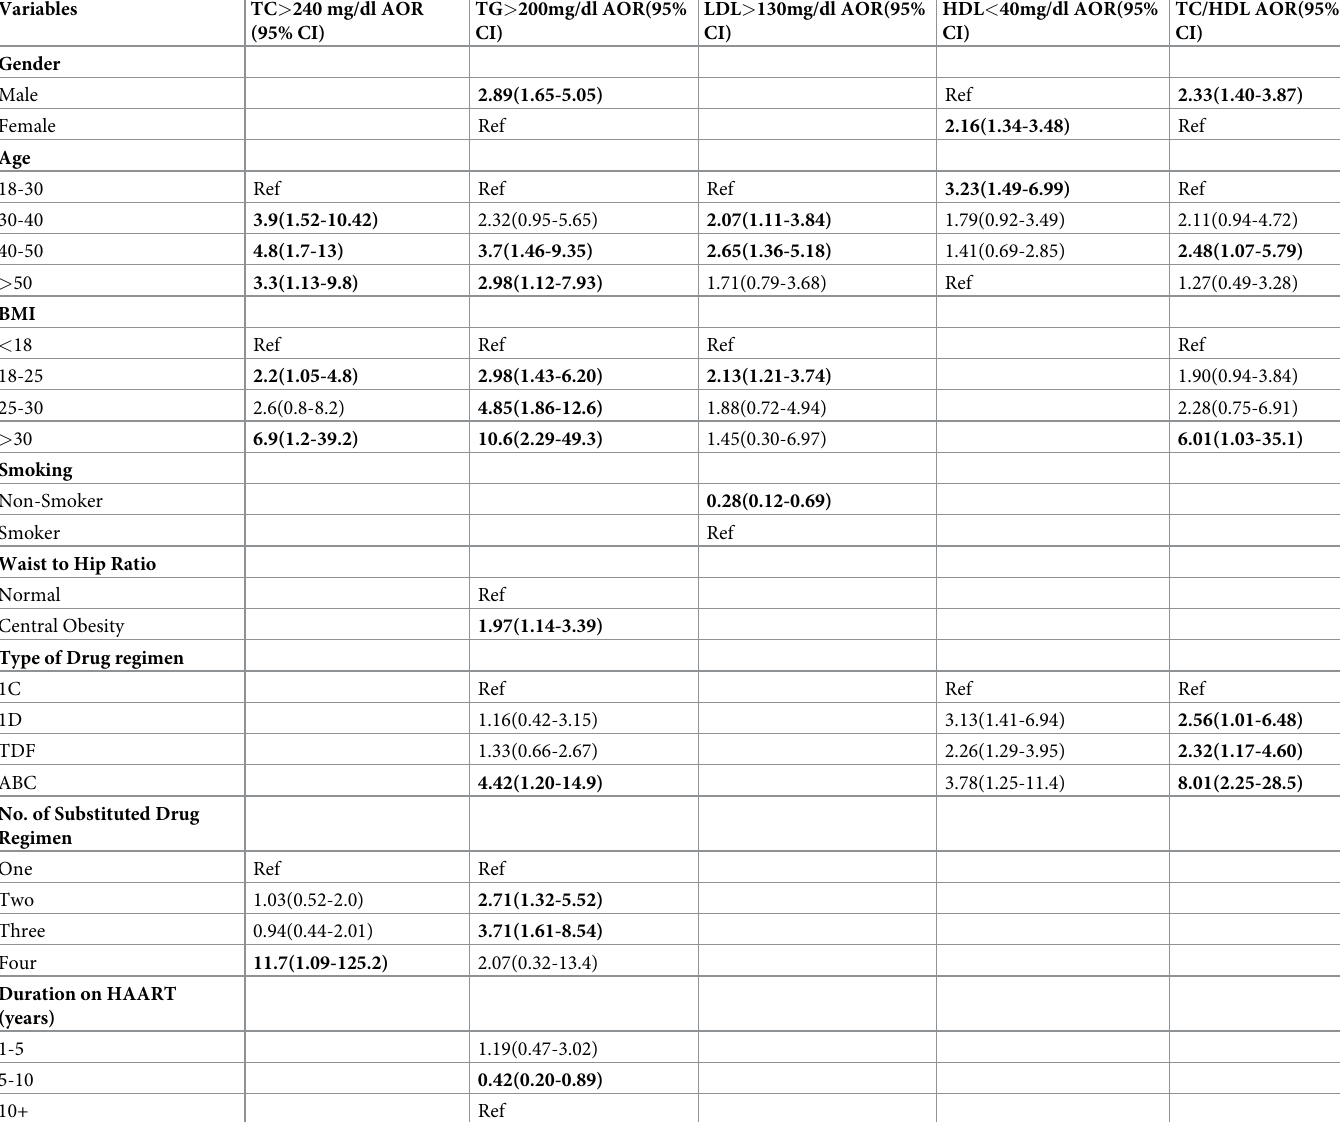
Table 6. Multivariate logistic regression model for factors associated with abnormal lipid profiles among HIV infected patients in Asmara, Eritrea.